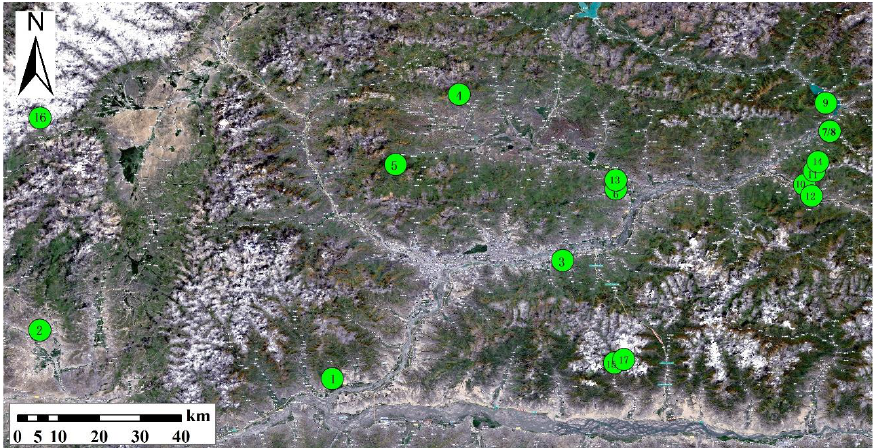
Figure 1. Sampling point map of metal tailings. Table 1. Specific mining situation of metal tailing sampling sites in Lhasa, Tibet.